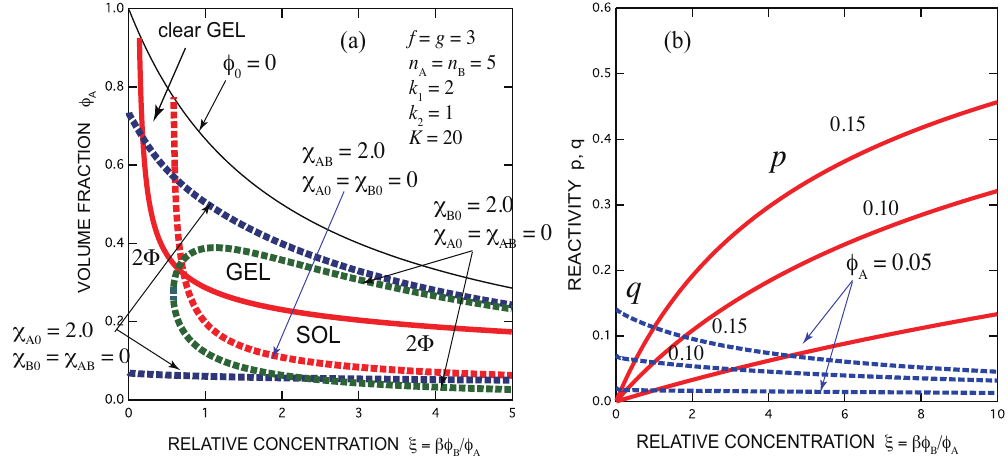
Figure 6. ( a ) Phase diagram for the mononuclear B cross-link junction. f = g = 3, ( k 1 , k 2 ) = ( 2,1 ) (sandwich cross-link). ) from below. There is no optimal concentration. SGT line (red line), The gel region is bound at ξ min = 1/ f (cid:48) ( g (cid:48) k 1 + k (cid:48) 1 spinodals for χ A , B = 2.0 (red broken line), for χ A ,0 = 2.0 (blue broken line), and for χ B ,0 = 2.0 (green broken line) are shown. Adding trifunctional B molecules promotes gelation monotonically with B concentration. For the repulsive interaction χ A , B = 2.0 in a good solvent χ A ,0 = χ B ,0 = 0, gelation takes place before the solution phase separates when the concentration of added B molecules is increased. Therefore, there is a uniform clear gel region at low concentration of B molecules. ( b ) Reactivity p (solid lines) and q (broken lines) shown as functions of the scaled B concentration for three fixed A concentrations. They are monotonic functions of B concentration, but different from those of ( 1,2 ) type cross-links in that q starts from finite